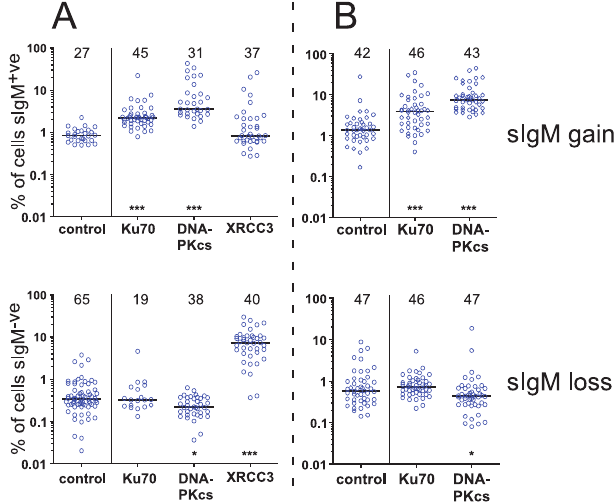
Figure 1. Surface Ig Reversion of DT40 Clones